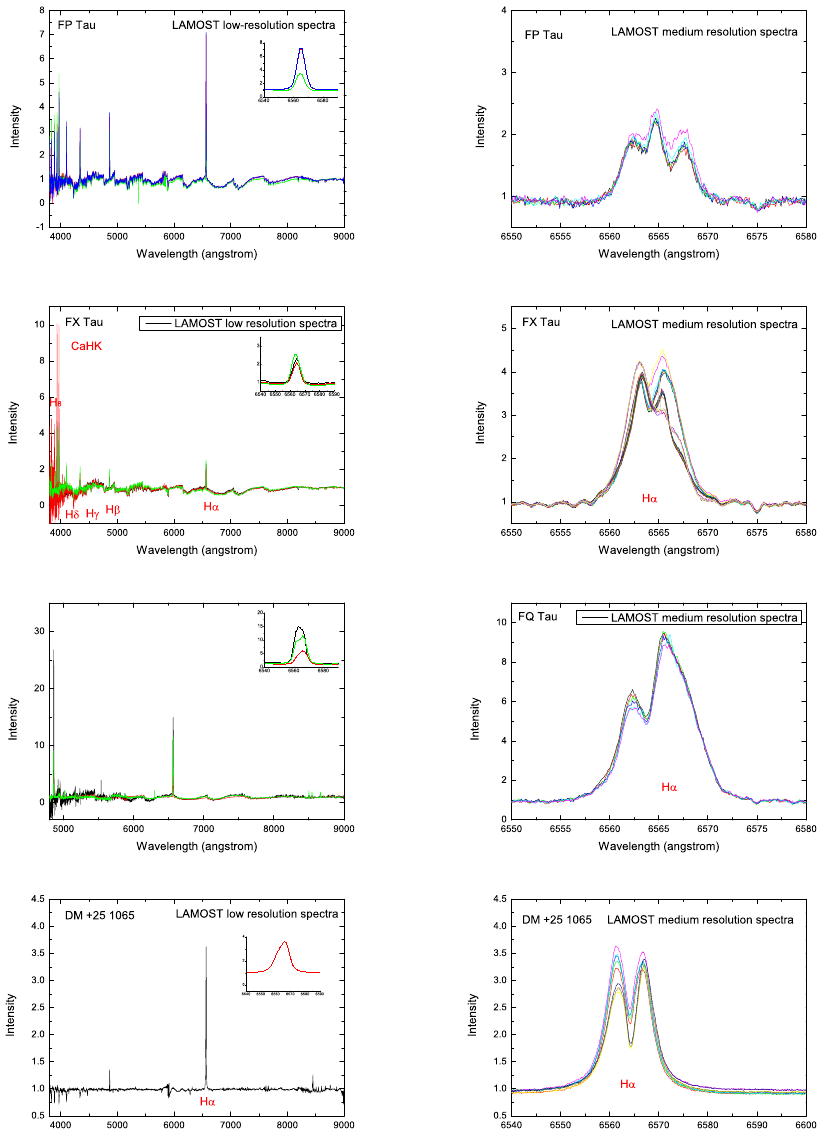
Figure 4. LAMOST spectra of radio stars with both low ( left ) and medium ( right ) resolution obser- vations. We marked several important spectral lines with obvious emissions in the Ca II H&K, H δ , H γ , H β , H α , and Ca II IRT lines. Detailed behavior of the H α line is shown in the small panels. The right panel shows the detailed behavior of LAMOST medium-resolution spectra, and different colors represent the different